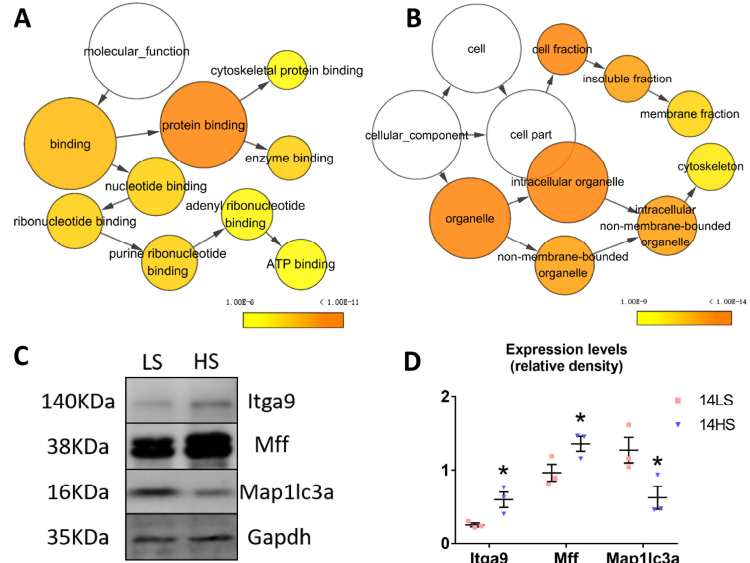
Figure 6. GO analyses and validation of dysregulated proteins identified by proteomics. ( A , B ) GO analysis of a gene network constructed from 80 di ff erential expression proteins (21 significantly downregulated and 59 significantly upregulated proteins). The color gradient of the cluster distribution network shows the p -value of each cluster with darker (orange) color for a lower p -value. ( A ) Molecular functions and ( B ) cellular components. ( C ) Western blot results showing expression levels of Itga9, M ff , and Map1lc3a in the two groups, where all data were normalized to Gapdh expression. ( D ) Statistical analysis of the intensity of the bands in Figure 6C using ImageJ software ( n = 3 for each group). * p <